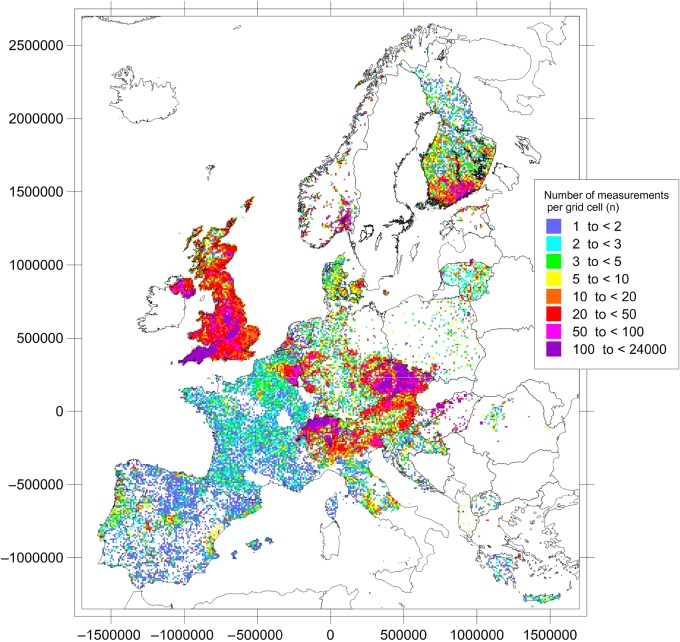
Number of measurements per 10 × 10 km grid cell. Data available until May 2014 included.